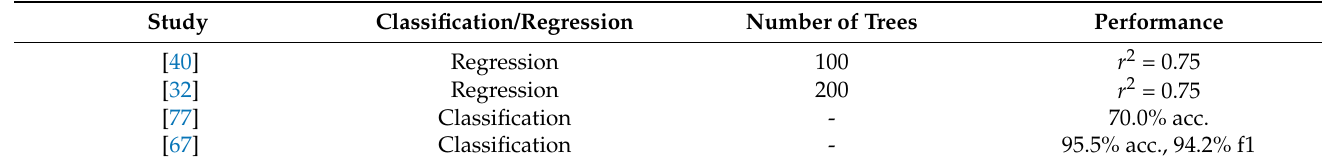
Table 4. Performance of Random